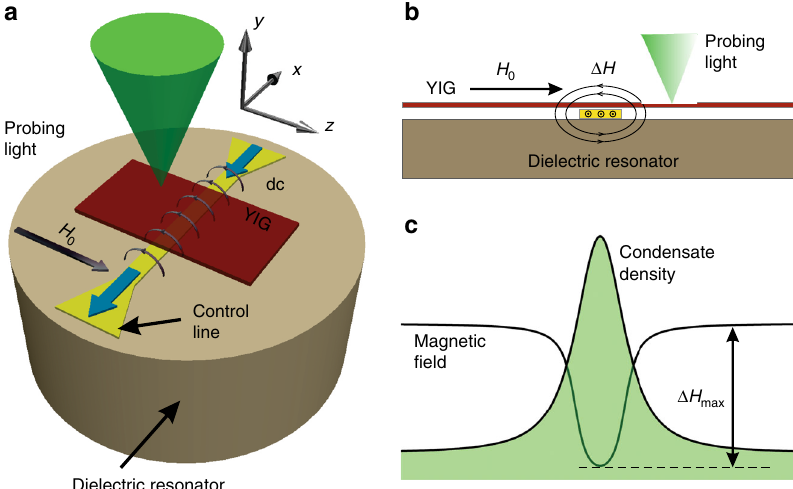
Fig. 1 Schematic of the experiment. a General view of the experimental system. Dielectric resonator creates a microwave-frequency magnetic fi eld, which parametrically excites primary magnons in the YIG fi lm. After thermalization, the magnons form BEC in the lowest-energy spectral state. dc electric current in the control line placed between the resonator and the YIG fi lm, produces a non-uniform magnetic fi eld, which adds to the uniform static fi eld H 0 . The local density of condensed magnons is recorded by BLS with the probing laser light focused onto the surface of the YIG fi lm. b Cross-section of the experimental system illustrating the fi eld created by the control line. c Spatial distribution of the horizontal component of the total magnetic fi eld H 0 + Δ H and the corresponding spatial pro fi le of the condensate density caused by the inhomogeneity of the fi